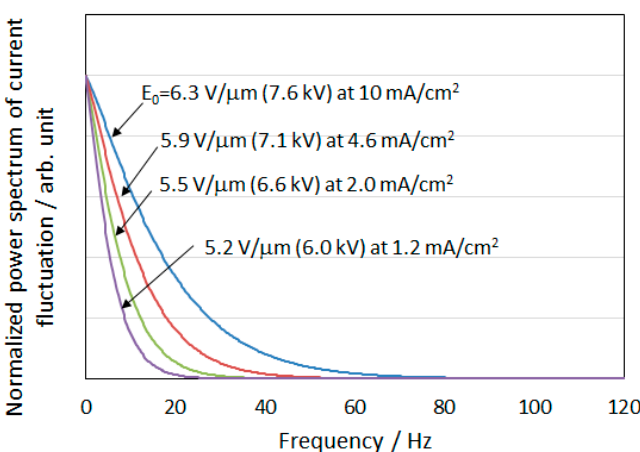
Figure 6. Dependence of power spectrum by simulation on the applied voltage. E 0 indicates the original field supplied between the cathode and anode electrodes.